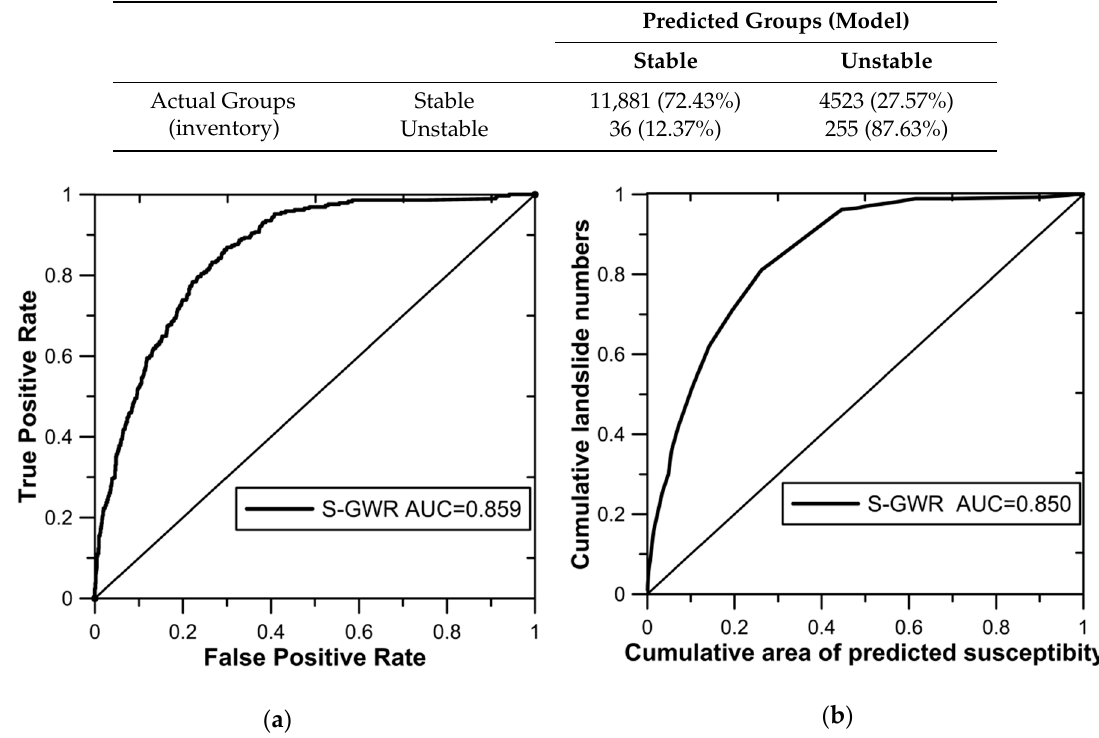
Figure 6. Validation of S-GWR model. ( a ) ROC curve; ( b ) success rate curve.